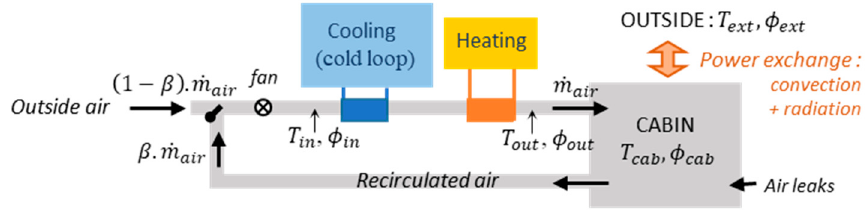
Figure 2. Schematic diagram of the HVAC system.